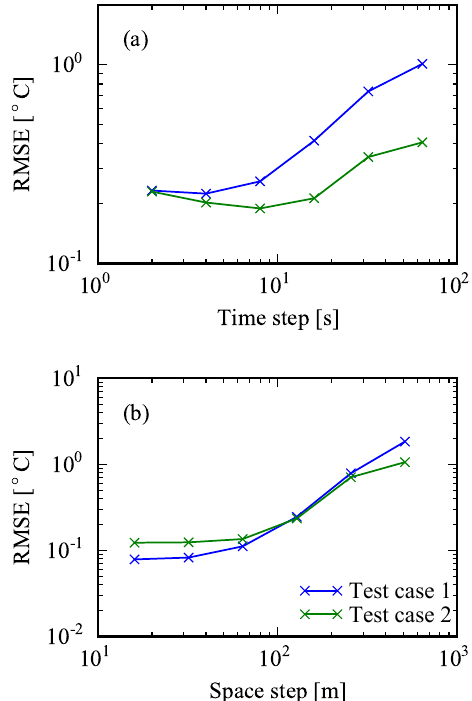
Figure B1. Root mean square error (RMSE) of the splitting scheme used to solve the heat-balance equation in test cases 1 (blue) and 2 (green). The RMSE is computed by comparing the simulated and analytical temperature profiles at the end of the simulation (8h). Panel (a) indicates the splitting scheme RMSE for various time steps with a fixed spatial discretization length of 128m, and (b) the splitting scheme RMSE for various spatial discretization lengths with a fixed time step of 1s.